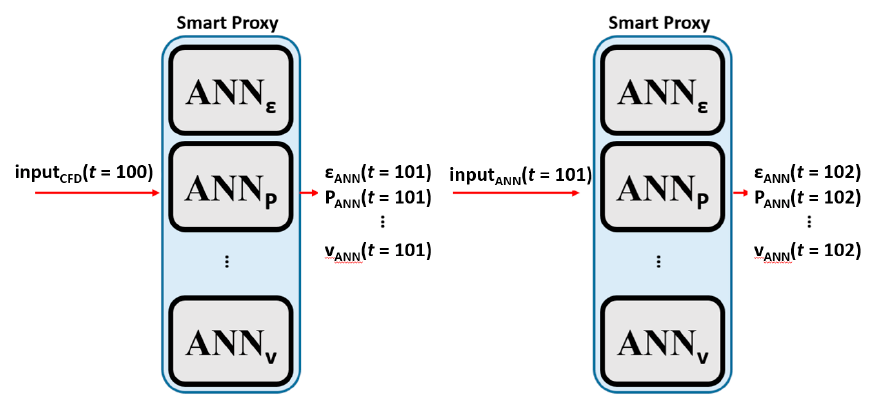
Figure 15. The process of non-cascading deployment. Fluids 2019 , 4 , x